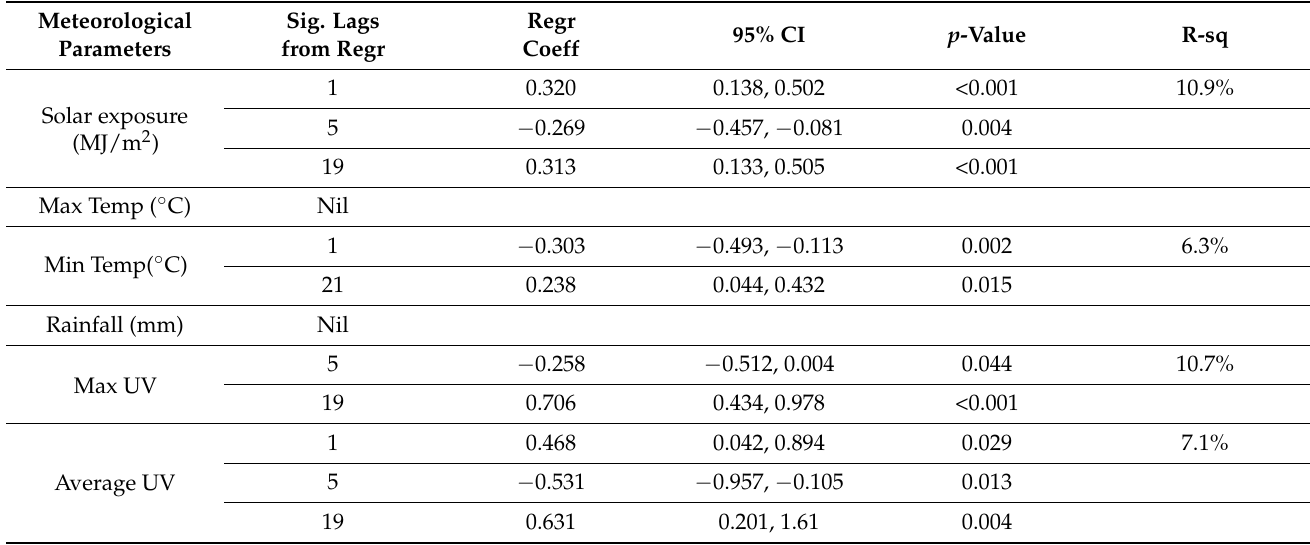
Results from regression analyses on the significant lags identified from the pre-whitening of each meteorological